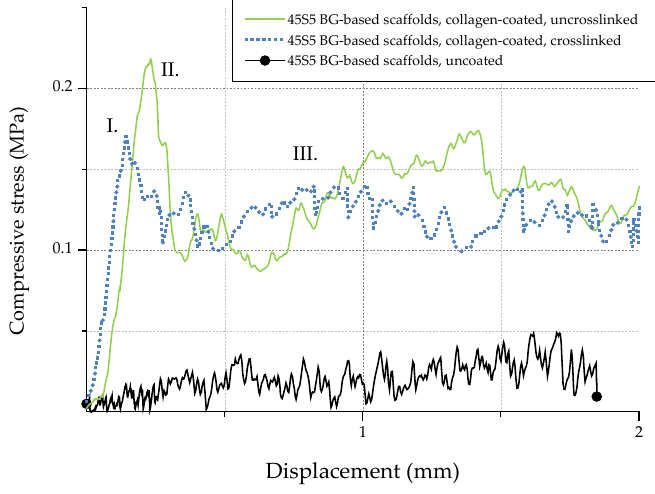
Figure 13. Exemplary stress-displacement curves for 45S5 BG-based scaffolds with and without collagen coating. collagen